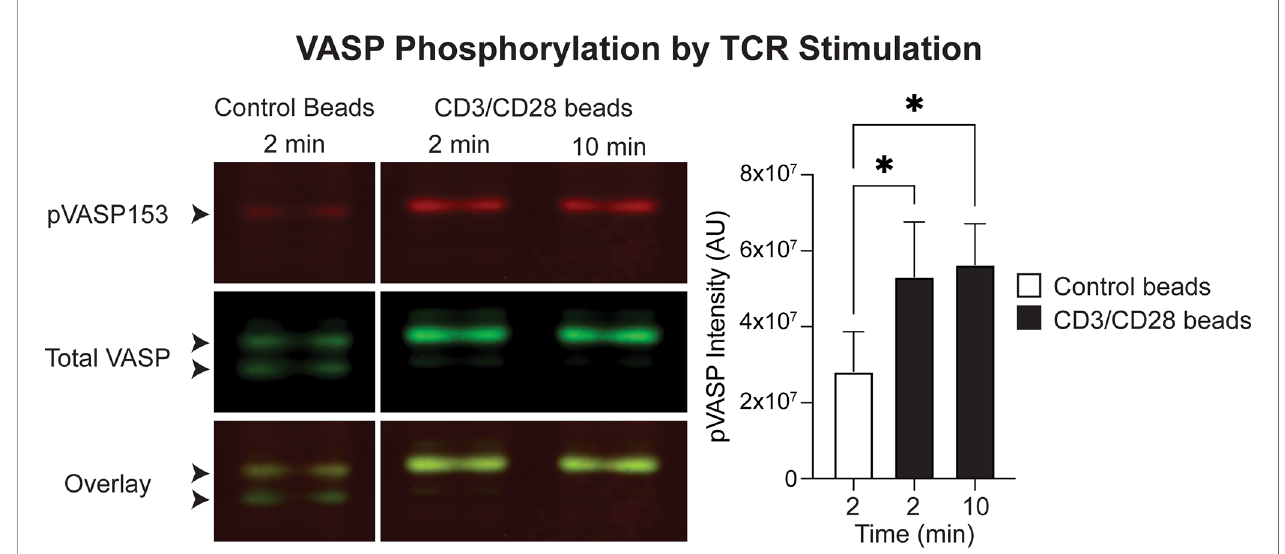
FIGURE 8 | VASP is activated downstream of CD3/CD28 stimulation in T cells. In vitro activated T cells were stimulated with control or anti-CD3/CD28 beads and VASP phosphorylation at S153 was determined by western blotting. Left; example western blot showing detection of total VASP and pVASP-S153. Arrowheads point to the VASP protein doublet: the bottom band is the non-phosphorylated isoform, and the top band is phosphorylated. Right; quanti fi cation of pVASP signal intensity, normalized to GAPDH intensity. Data is from a total of 3 independent experiments. Statistics were performed using a one-way repeated measures ANOVA; * is p <